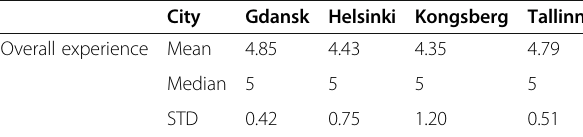
Table 5 Mean and median of the distribution of the score about the overall experience